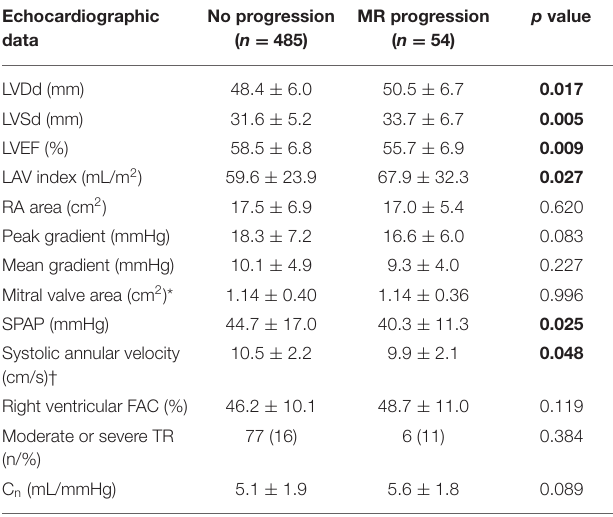
TABLE 2 | Baseline echocardiographic characteristics of the study population stratified by MR progression. Echocardiographic